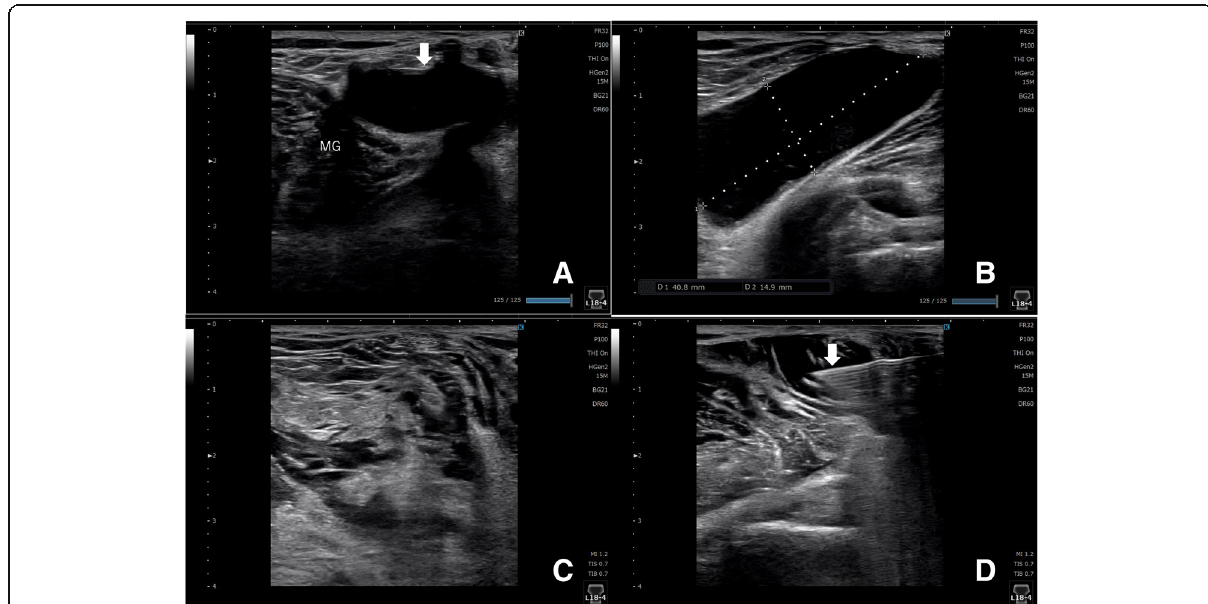
Fig. 2 Ultrasound findings of the right knee before and after communication enlargement. a The short-axis view of the cyst (thin white arrow). b The long-axis view of the cyst and its size. c The size of the cyst is obviously reduced. d A periarticular multimodal drug is injected under